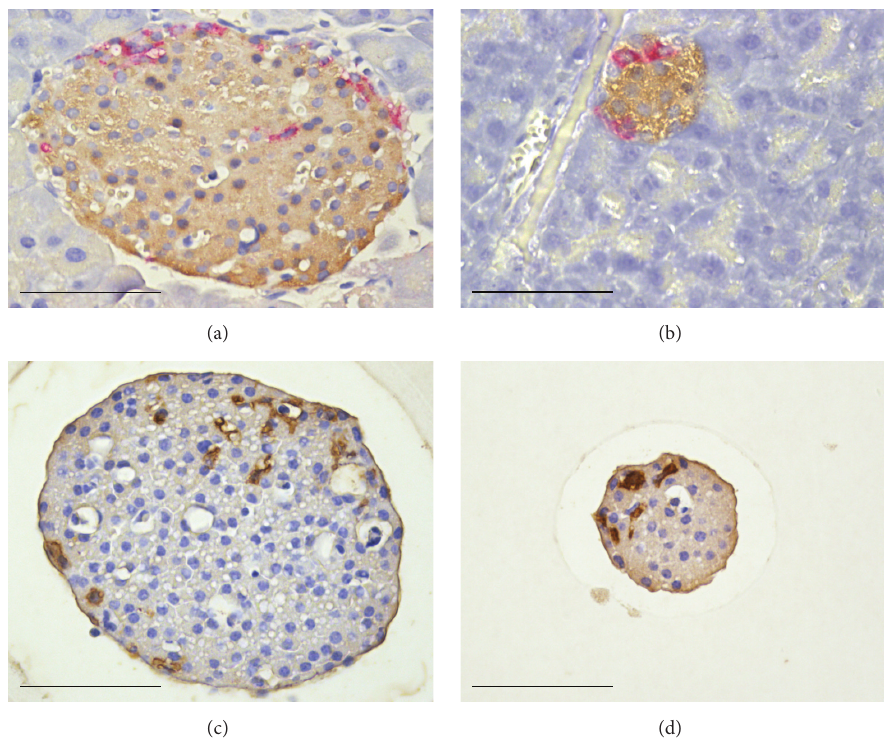
Figure 3: Double immunostaining of a big islet (a) and a small islet (b) in the pancreas for somatostatin (red) and insulin (brown). Immunostaining of an isolated big islet (c) and an isolated small islet (d) for somatostatin (brown). The somatostatin-producing 𝛿 -cells are located in both the core and periphery of the islets. Scale bars represent 50 𝜇 m.